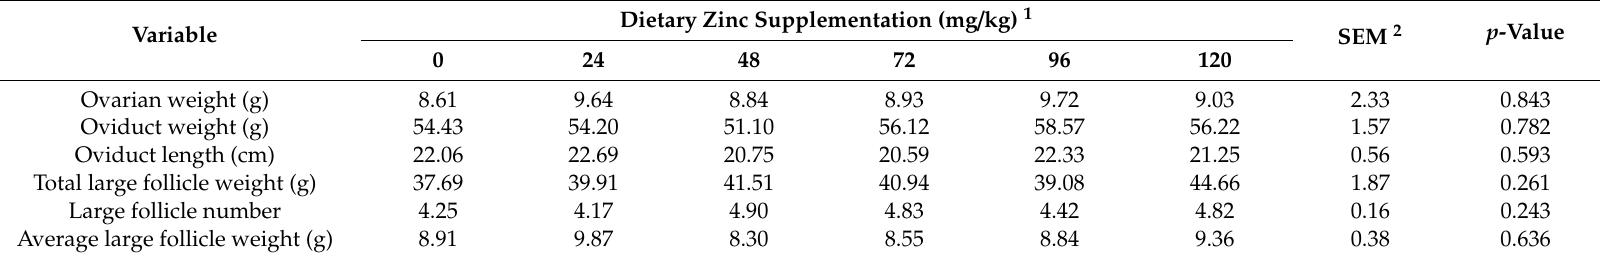
Table 6. E ff ects of dietary zinc supplementation on reproductive organs and follicle development of Chinese yellow-feathered broiler breeders aged 65 weeks.